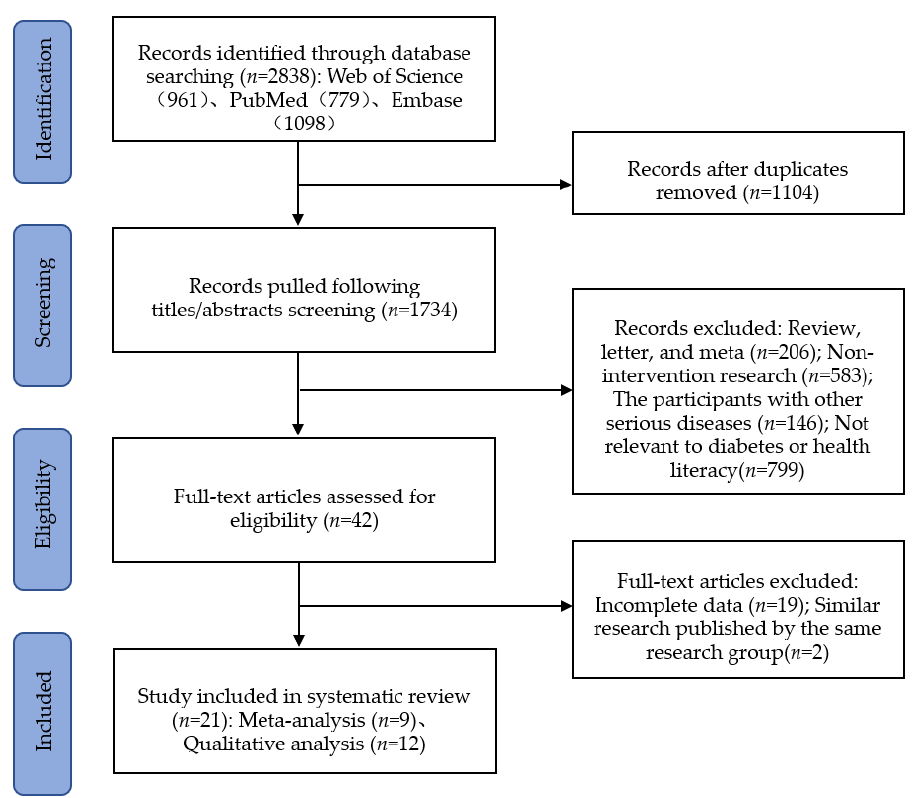
Figure 1. Flow diagram of study